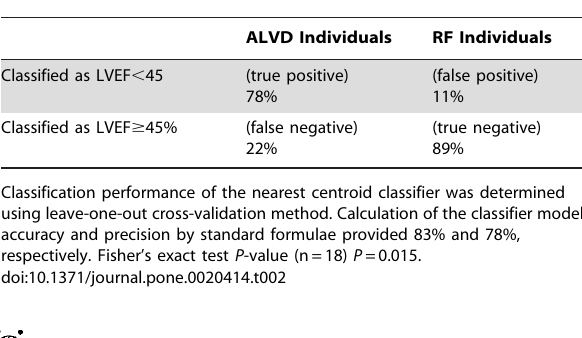
ALVD Individuals RF